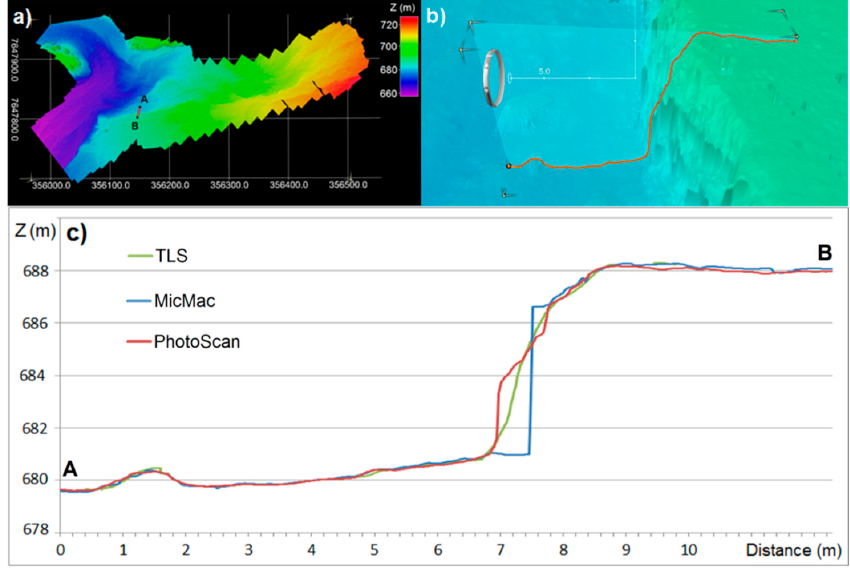
Figure 9. ( a ) Location map of the selected profile on the PhotoScan DSM of the study area; ( b ) 3D view (on PhotoScan DSM) of the profile over a terrace front; ( c ) Comparison of the vertical profiles extracted from PhotoScan DSM, MicMac DSM and the TLS point cloud.